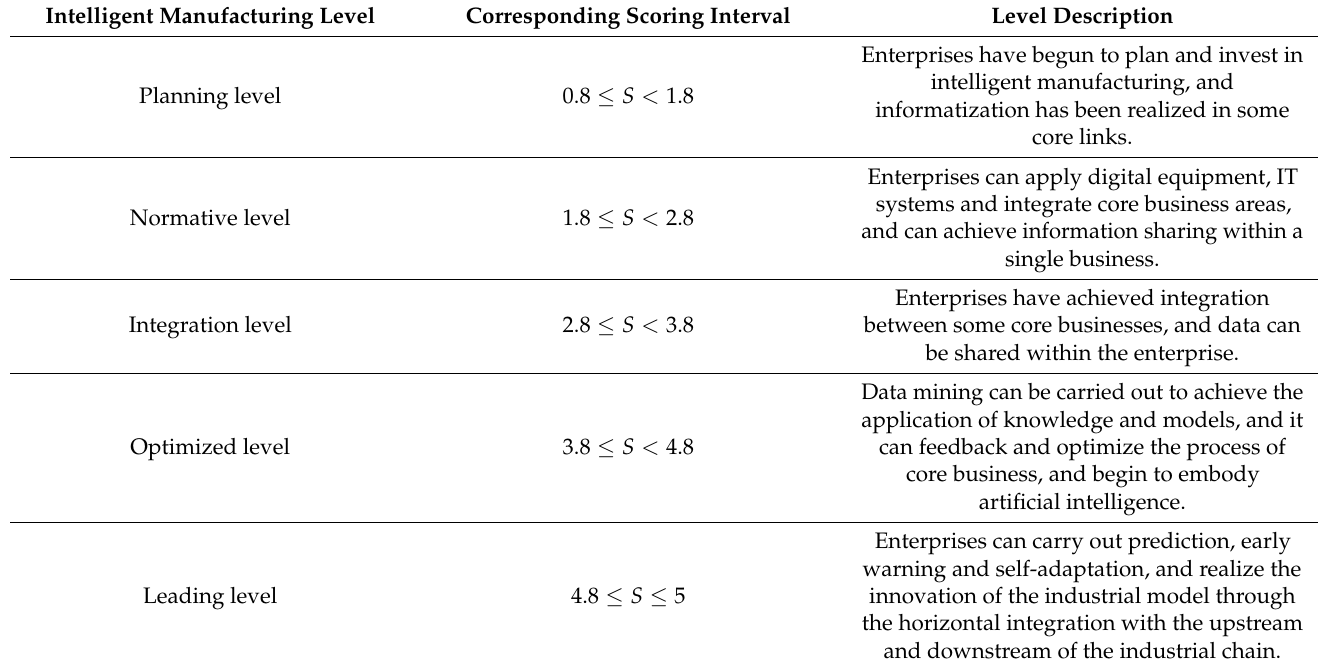
Table 1. Maturity levels and